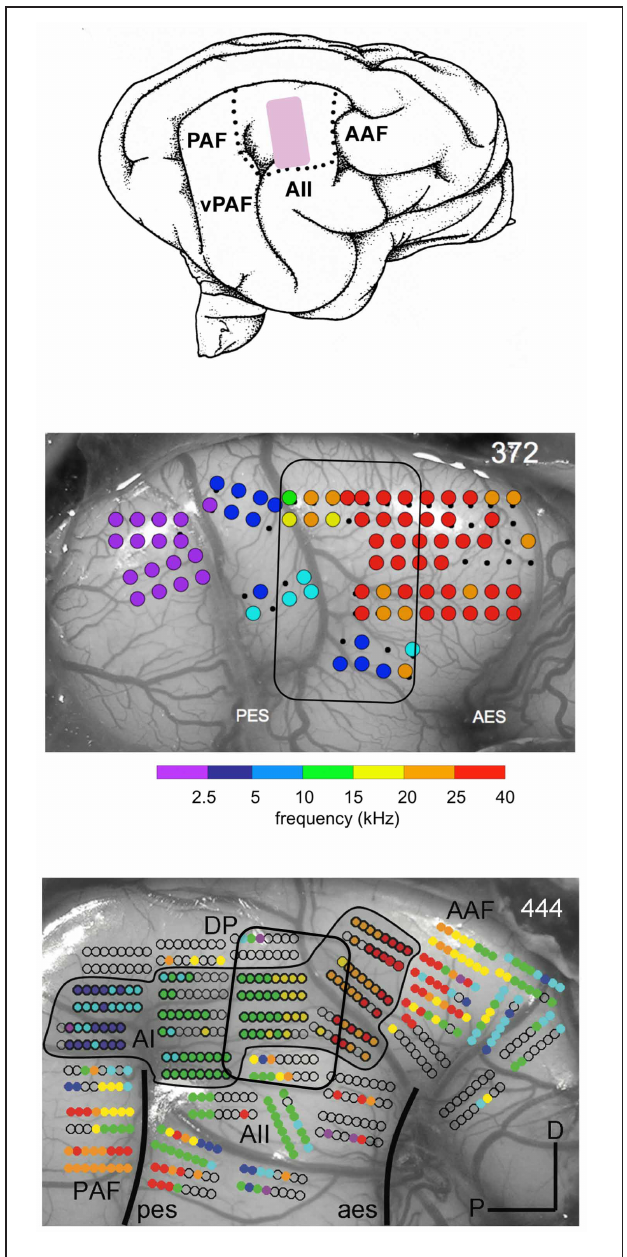
FIGURE 2 | Map of best frequencies at 65dB SPL ontothe cortical surface in a normalhearing adult cat reared in an enhanced acoustic environment(4–20kHz) presentedforat least 5mo at80dBSPL(middle panel). Forcomparison themapinanunexposed normalhearing catisshown inthebottompanel.Thecartoon oftheauditory fields(toppanel)indicates the region (pink) where the 4–20kHz are normally represented. In the outlined region in the EAEcat there is a lack of responses to frequencies in the range of 5–20kHz and an overrepresentation of frequencies above 25kHz. From Eggermont (2008) and Pienkowski and Eggermont